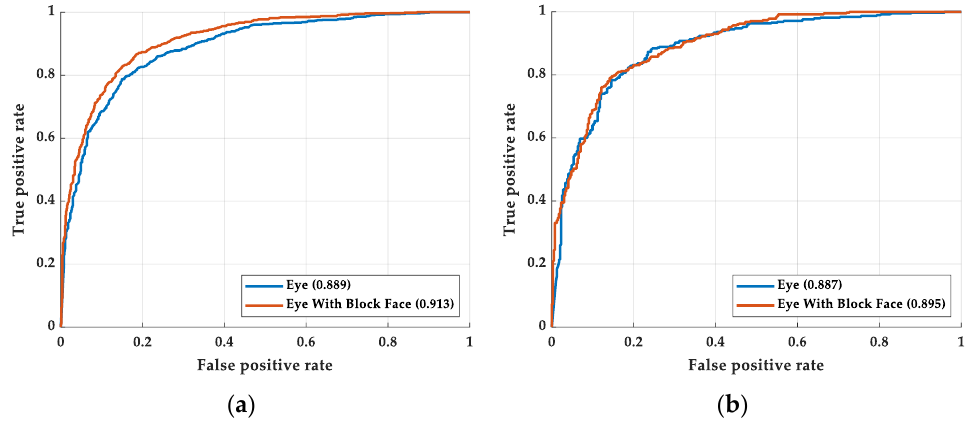
Figure 13. The ROC curve of the eye image with gender signal: ( a ) training process and ( b ) testing process.